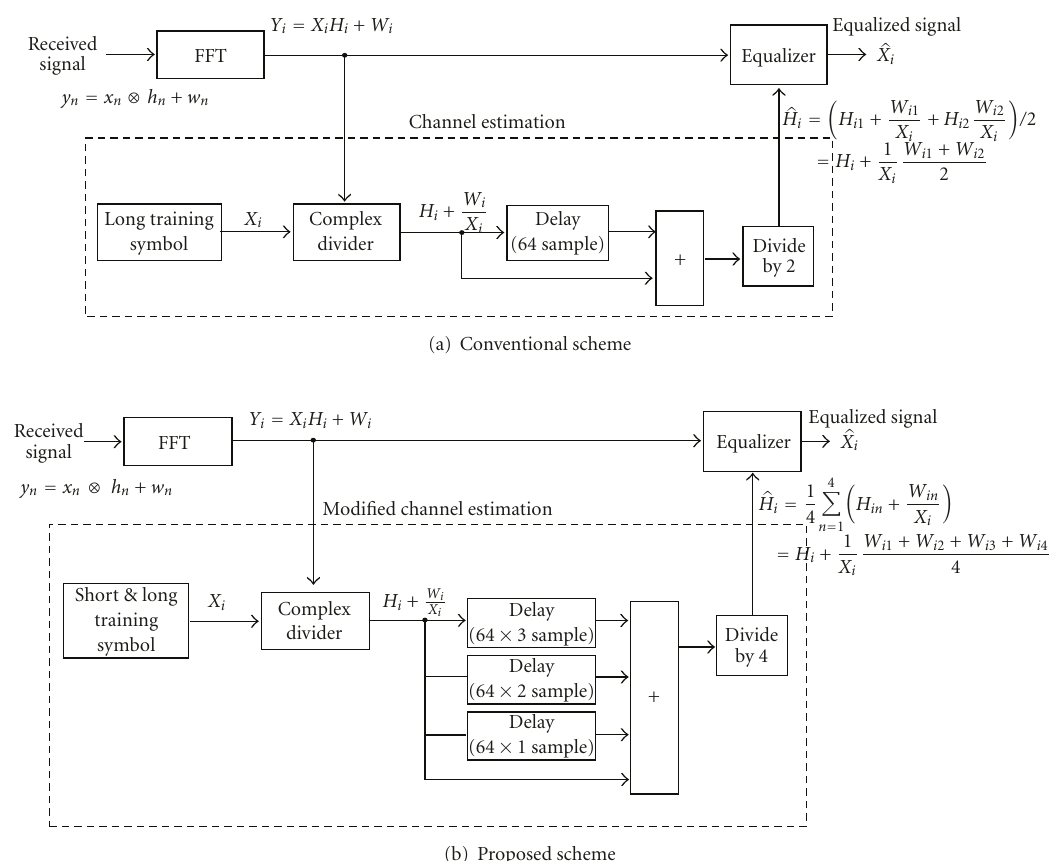
Figure 7: Conventional and proposed channel estimation